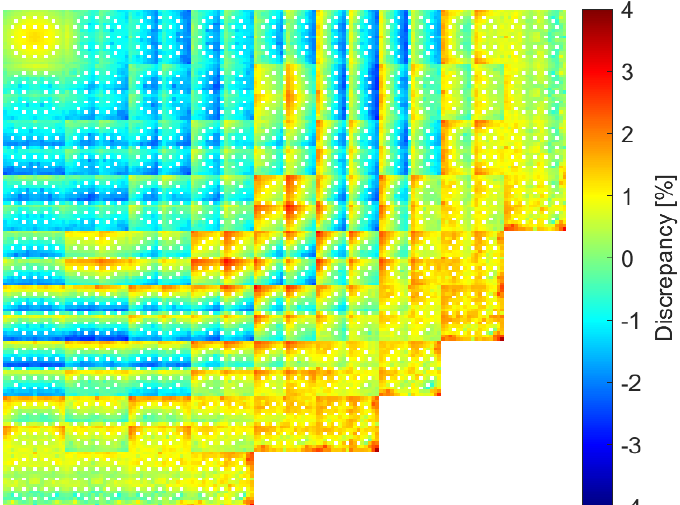
Figure 5. Radial pin power discrepancy for EPR core between Tortin and